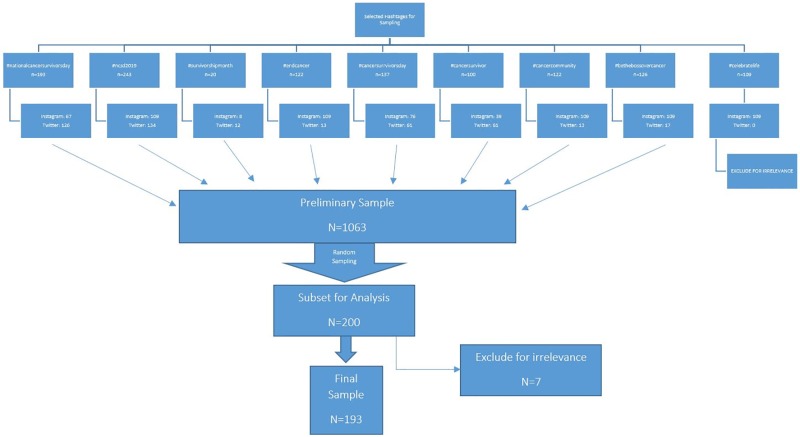
Sampling strategy.